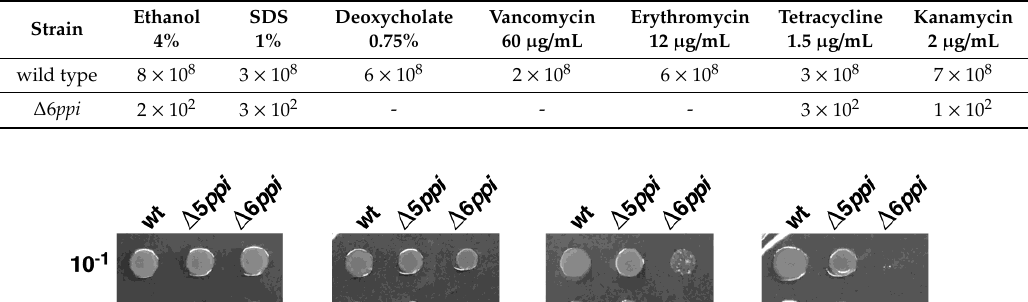
Table 1. The sensitivity of a Δ6 ppi derivative on M9 medium supplemented with different agents at 37 °C. Exponentially grown cultures were adjusted to an optical density OD 600 of 0.2 and spot diluted. Numbers indicate the colony forming units of a Δ6 ppi derivative as compared to the wild type.